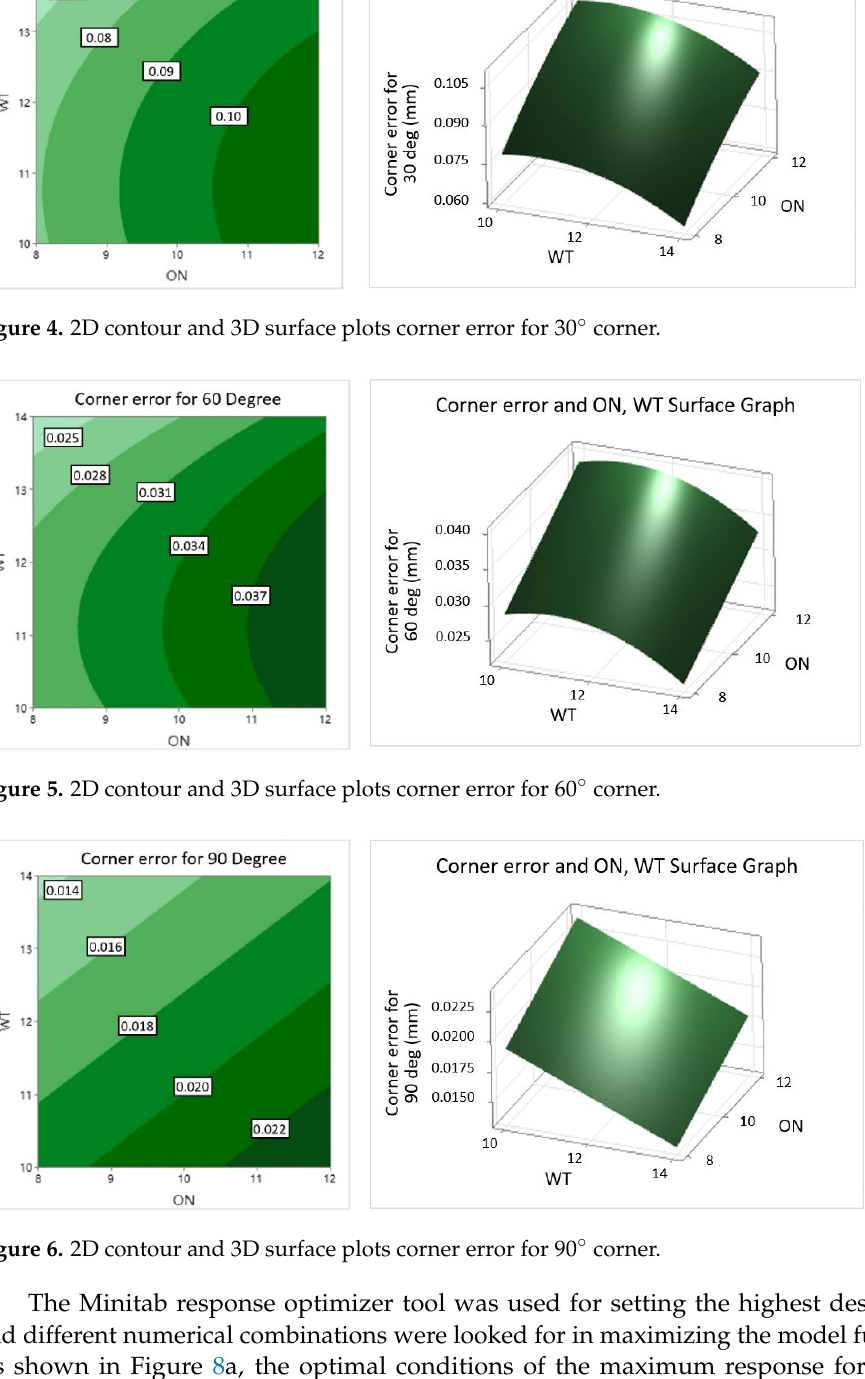
Figure 7. 2D contour and 3D surface plots for machining speed.